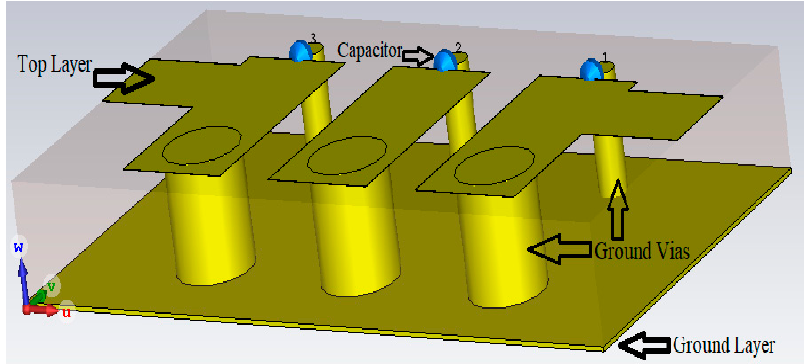
Figure 1. 3D configuration of the Combline BPF filter [38].